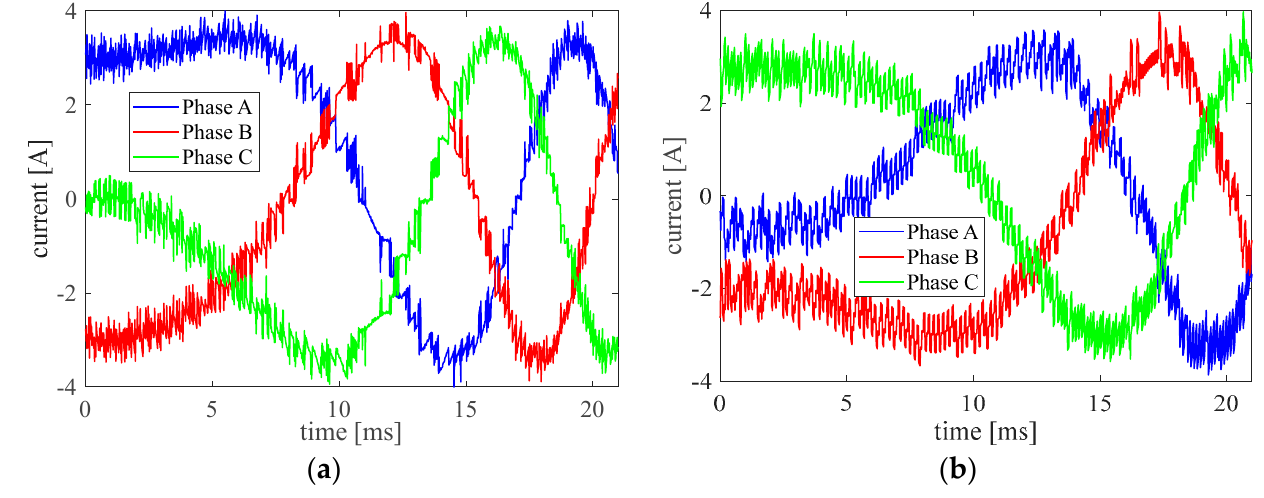
Figure 9. The current of three phases. ( a ) MPDTC, ( b ) FOC.